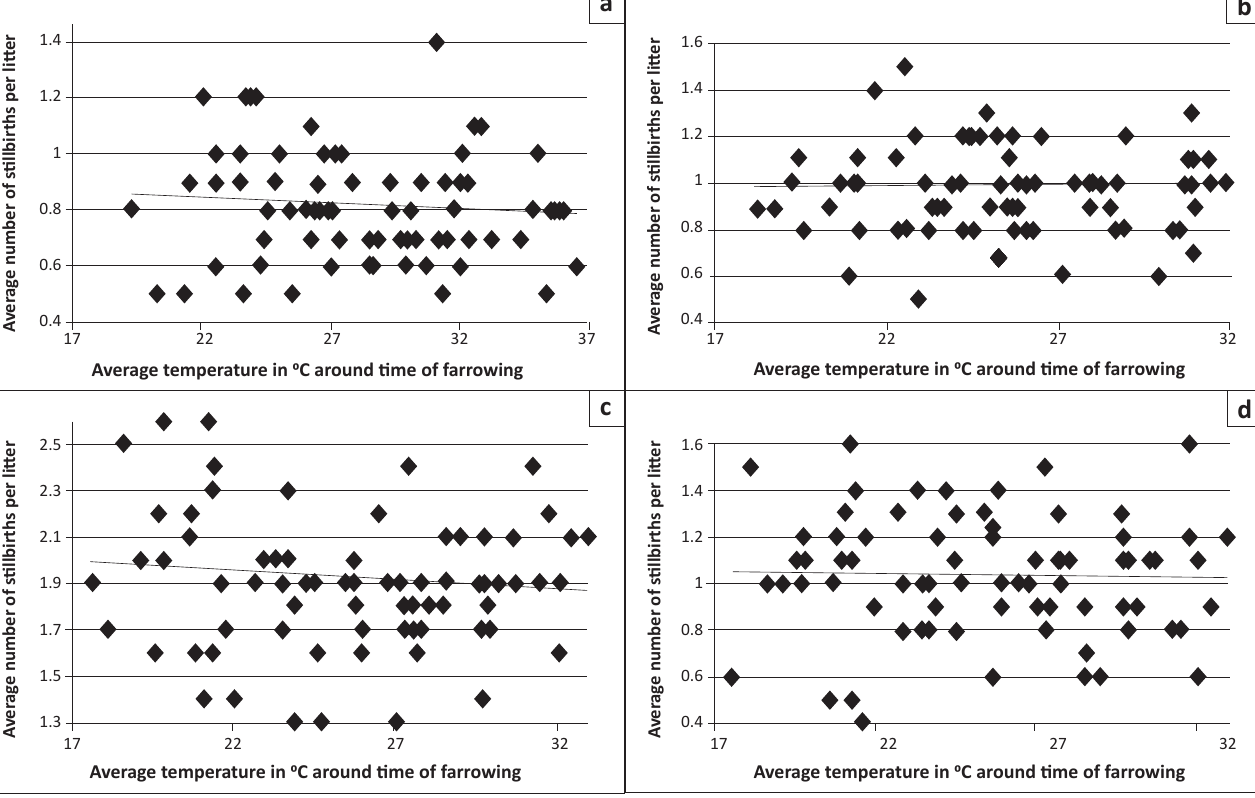
FIGURE 4: The effect of various temperatures around the time of farrowing on the number of stillbirths. (a) Breeding unit 1, (b) breeding unit 2, (c) breeding unit 3 and (d) breeding unit 4.